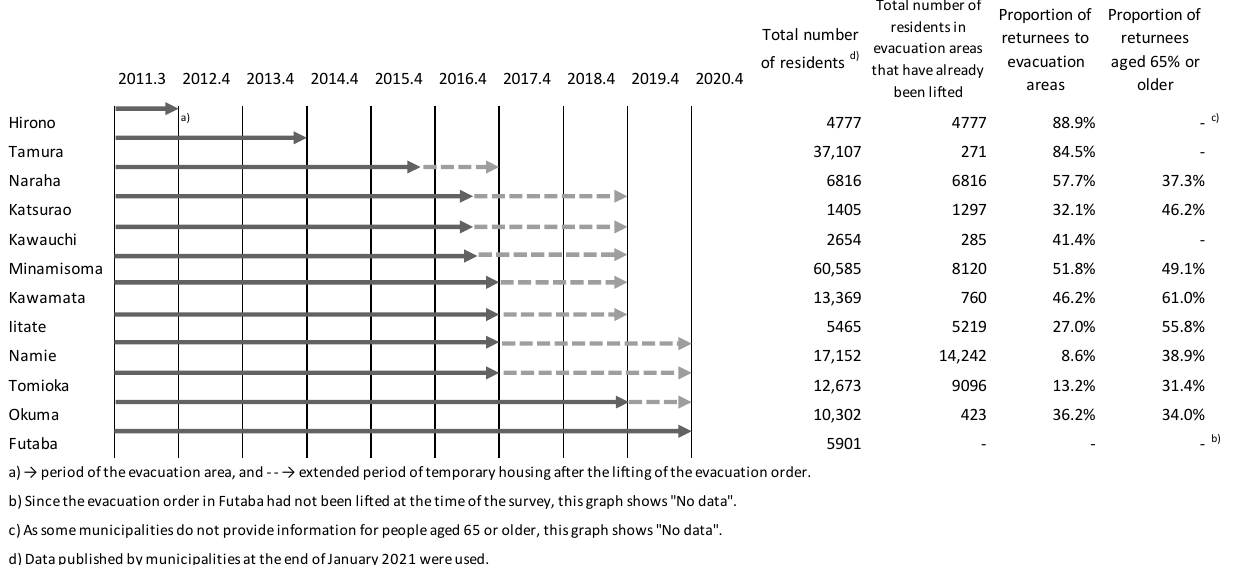
Figure 1. Periods of evacuation order and information on population dynamics. Annual suicide rates were calculated for each of the 12 designated municipalities and for the non-evacuation areas by adding the monthly number of suicides in each municipality and dividing the total by the Basic Resident Register population, in order to exclude the effect of seasonal variation of suicide rate (exponential smoothing time series model). Then suicide rates were analyzed by age categories using a 2-year simple